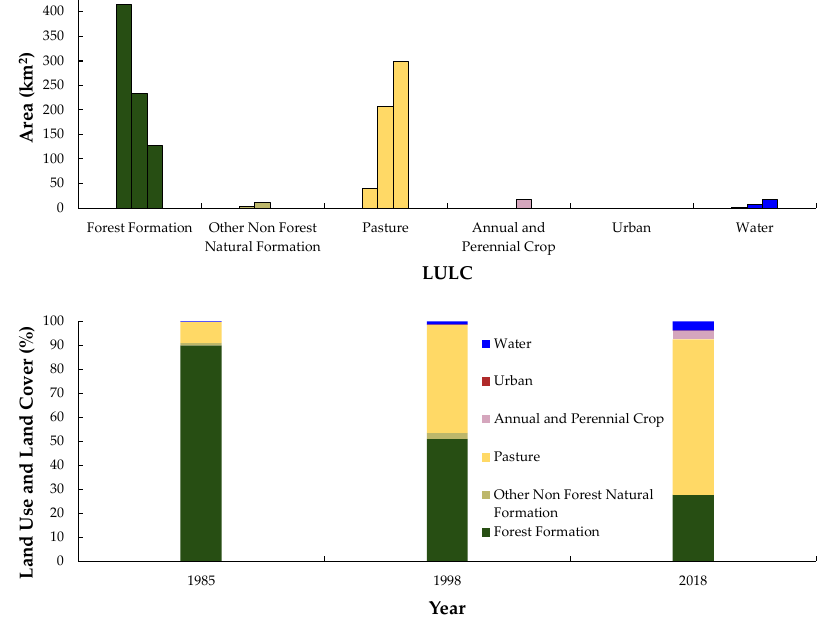
Figure 3. Annual total area (km 2 ) and percentage of the LULC classes identified in the direct influence zone of the Braço Norte Hydropower Complex in 1985, 1998, and 2018.